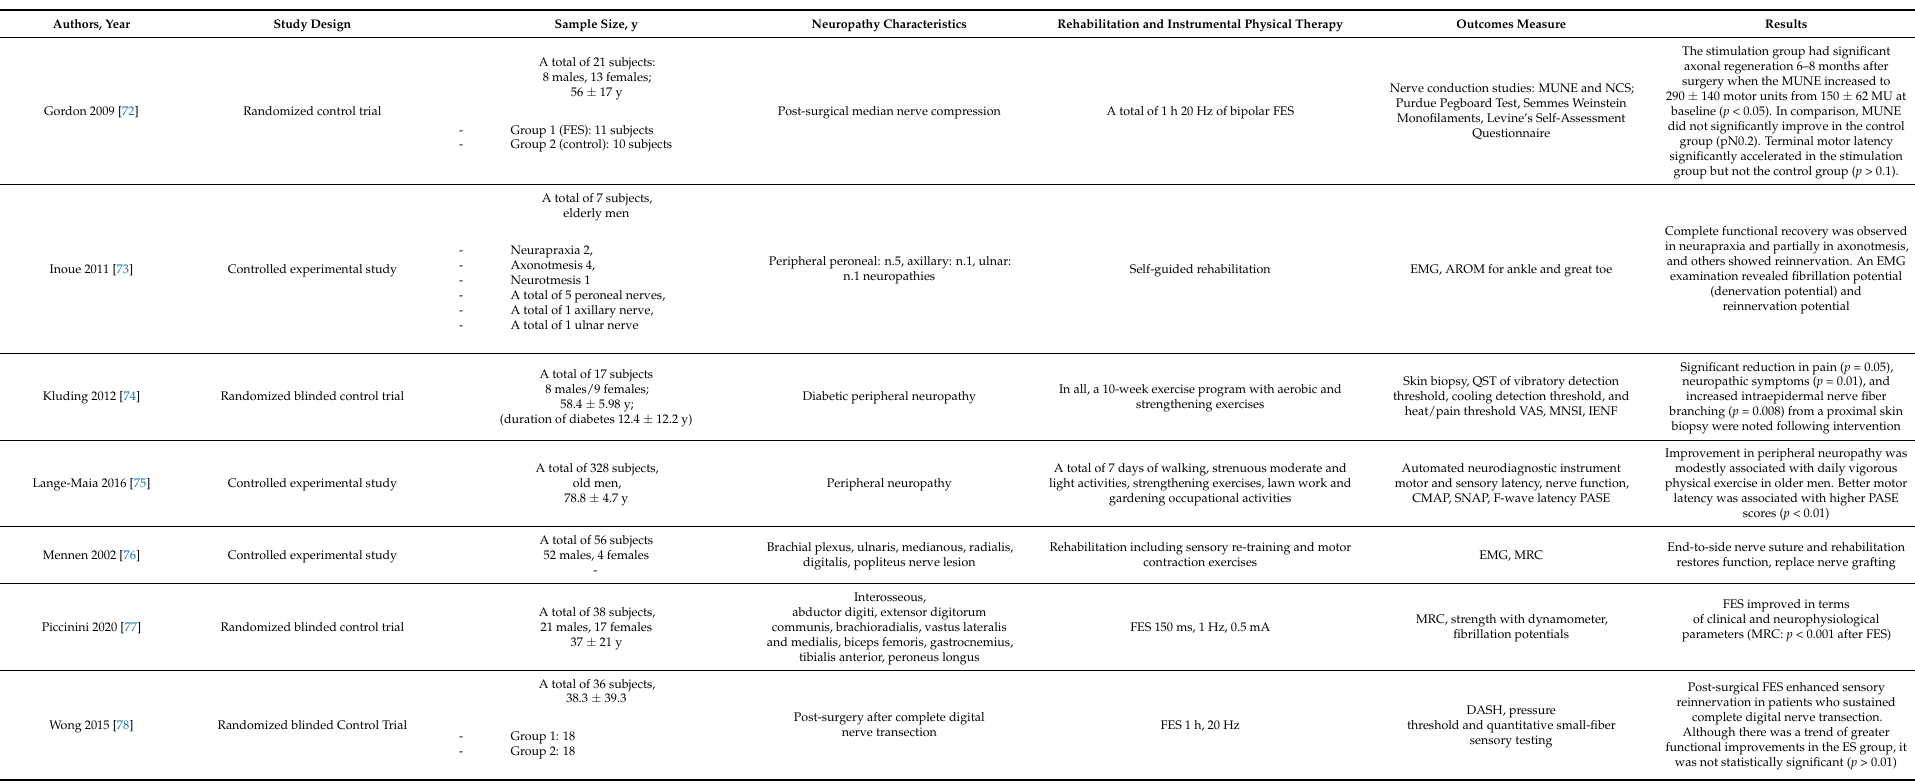
Table 2. Physical exercise in peripheral neuropathy in humans: characteristics and outcomes of studies included in the systematic